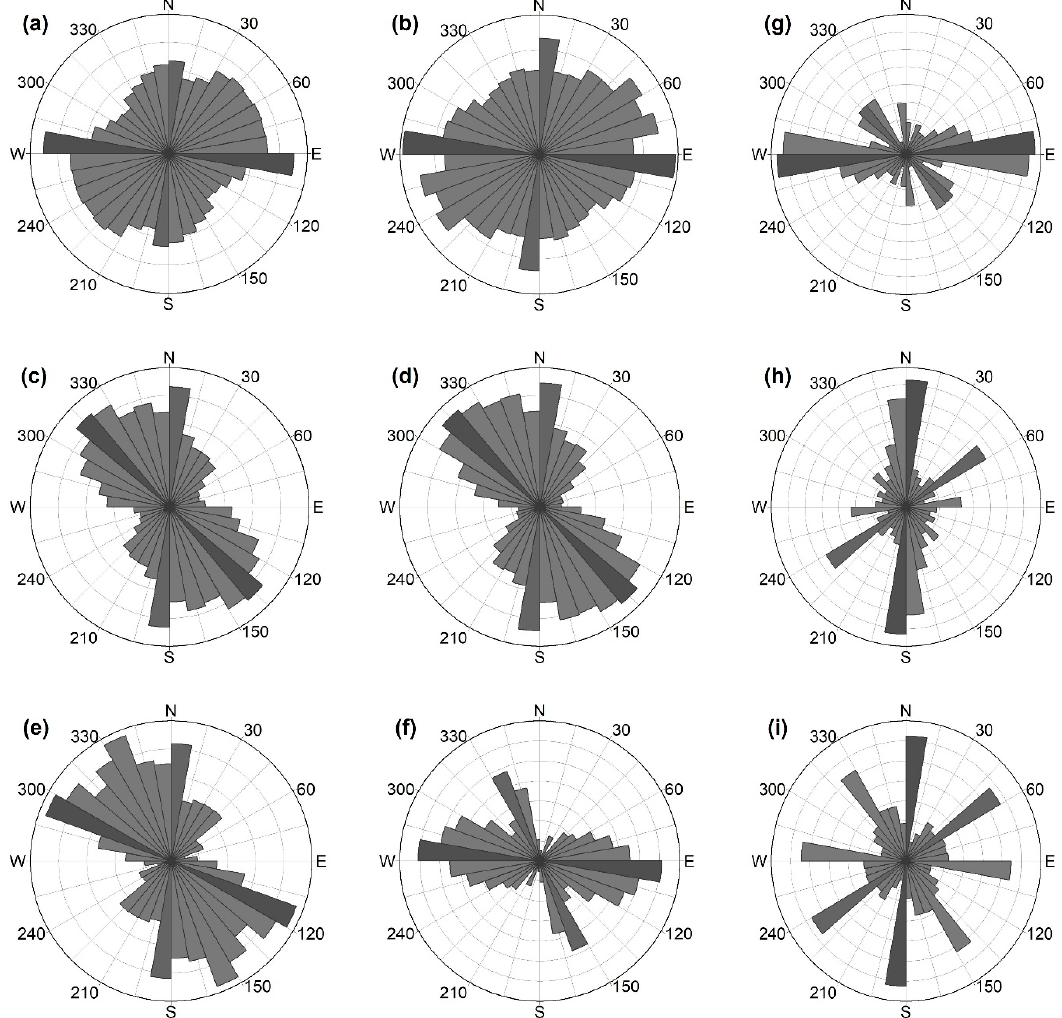
Figure 13. Rose diagrams showing the orientations of lineaments extracted from the ( a ) OLI, ( b ) S2A, ( c,d ) S1A VH and VV polarizations respectively, and ( e ) directionally filtered images in comparison to those of ( f ) the faults digitized from a geologic map, ( g , h ) the bedding directions of strata-strike azimuths and dipping azimuths respectively, and ( i ) the drainage network orientations of the study area